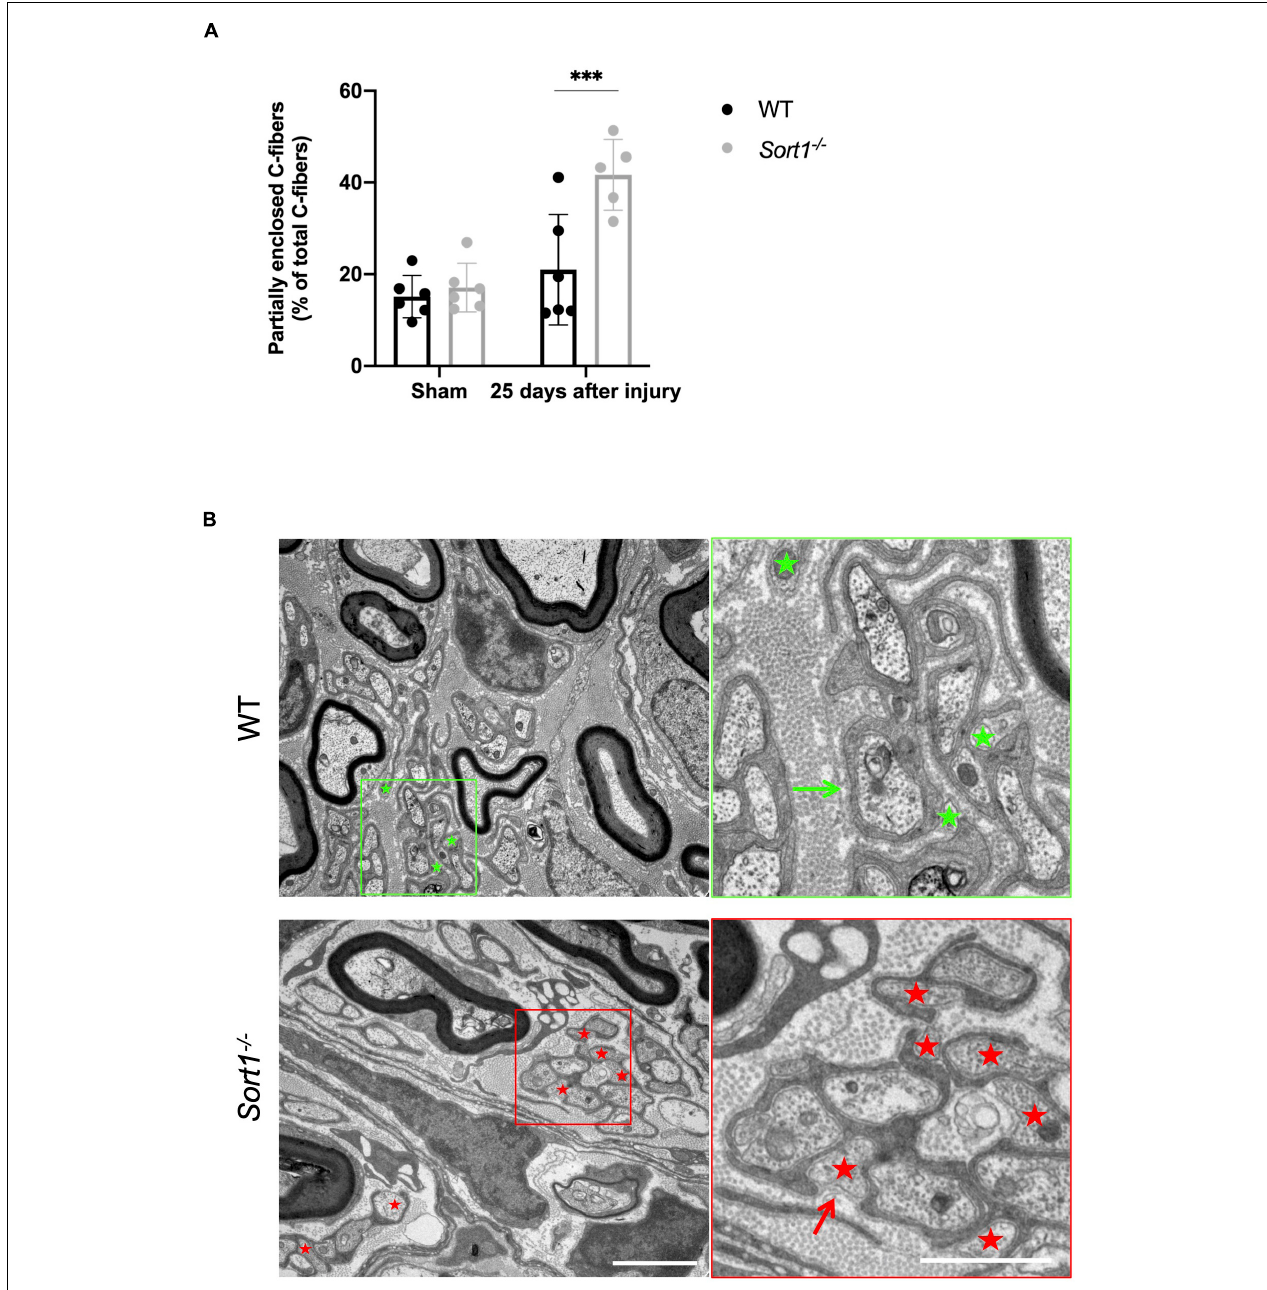
FIGURE 3 | Reduced axon ensheathment by Remak Schwann cells in regenerated Sort1 − / − sciatic nerve. Significantly more partially enclosed C-fibers were observed in the injured Sort1 − / − sciatic nerve compared to WT. Representative images showing normal Schwann cell ensheathment of C-fibers in injured WT sciatic nerve 25 days after crush injury (indicated by the green arrow) and only partly enclosure of C-fibers by Schwann cell cytoplasm and partly by only basement membrane 25 days after sciatic nerve crush injury in WT (green stars) and the Sort1 − / − mouse (indicated by red stars and red arrows). Scale bars: left images 2 µ m, right images (zoom of left) 1 µ m. (A,B) N = 6 WT mice and 6 Sort1 − / − mice. Statistical significance was established with two-way ANOVA and Bonferroni’s multiple comparisons post hoc test ( ∗∗∗ p <